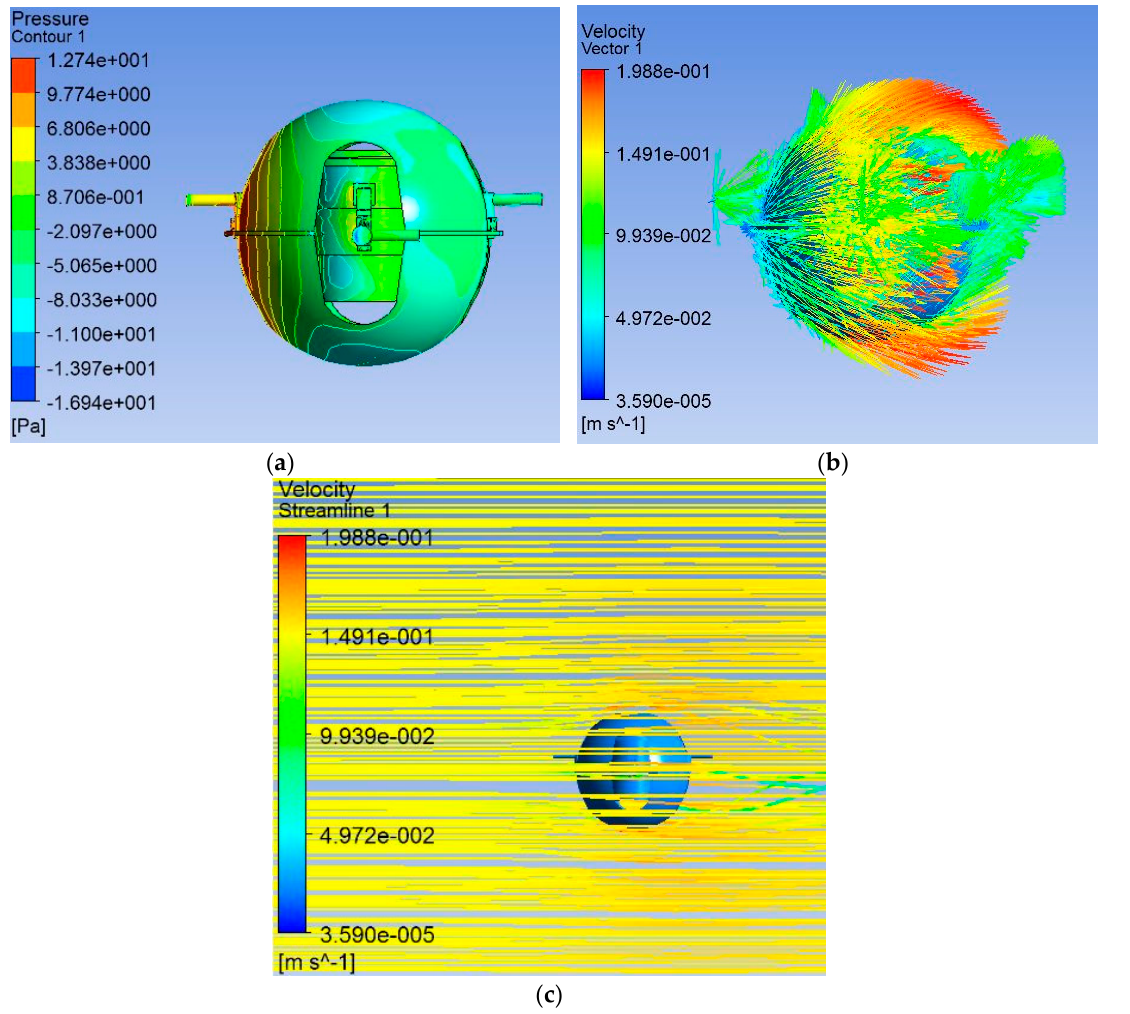
Figure 17. Forward motion in surge. ( a ) Pressure contour; ( b ) Velocity vector; ( c ) Velocity streamline.